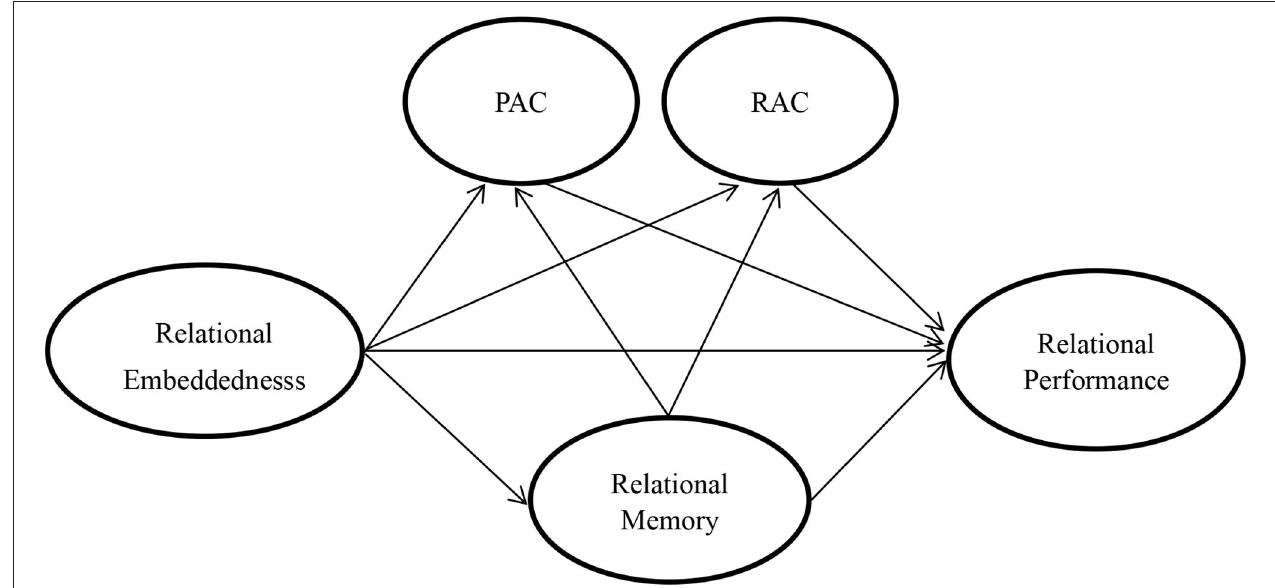
FIGURE 1 | Research